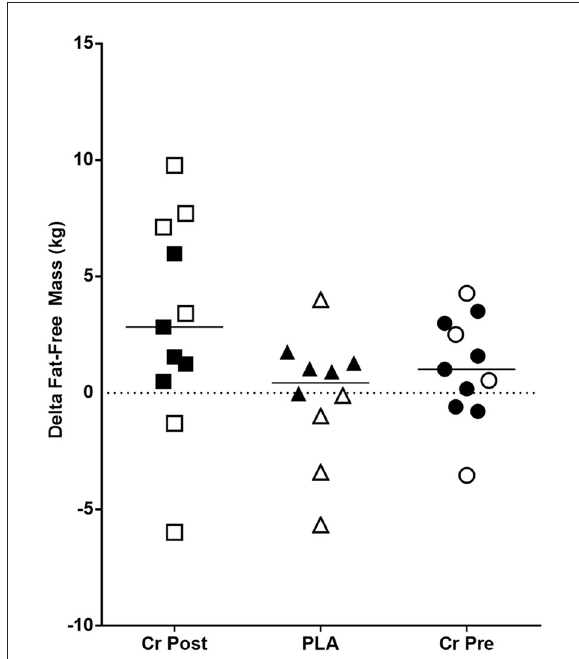
FIGURE3 Change in fat-free mass (Week 8 - Week 0) in kilograms. Cr Post, Post-exercise creatine supplementation; Cr Pre, Pre-exercise creatine supplementation; PLA, Placebo supplementation. For each respective shape, the filled shapes ( (cid:4)N • ) are female participants, and the non-filled shapes ( △ ◦ (cid:3) ) are male